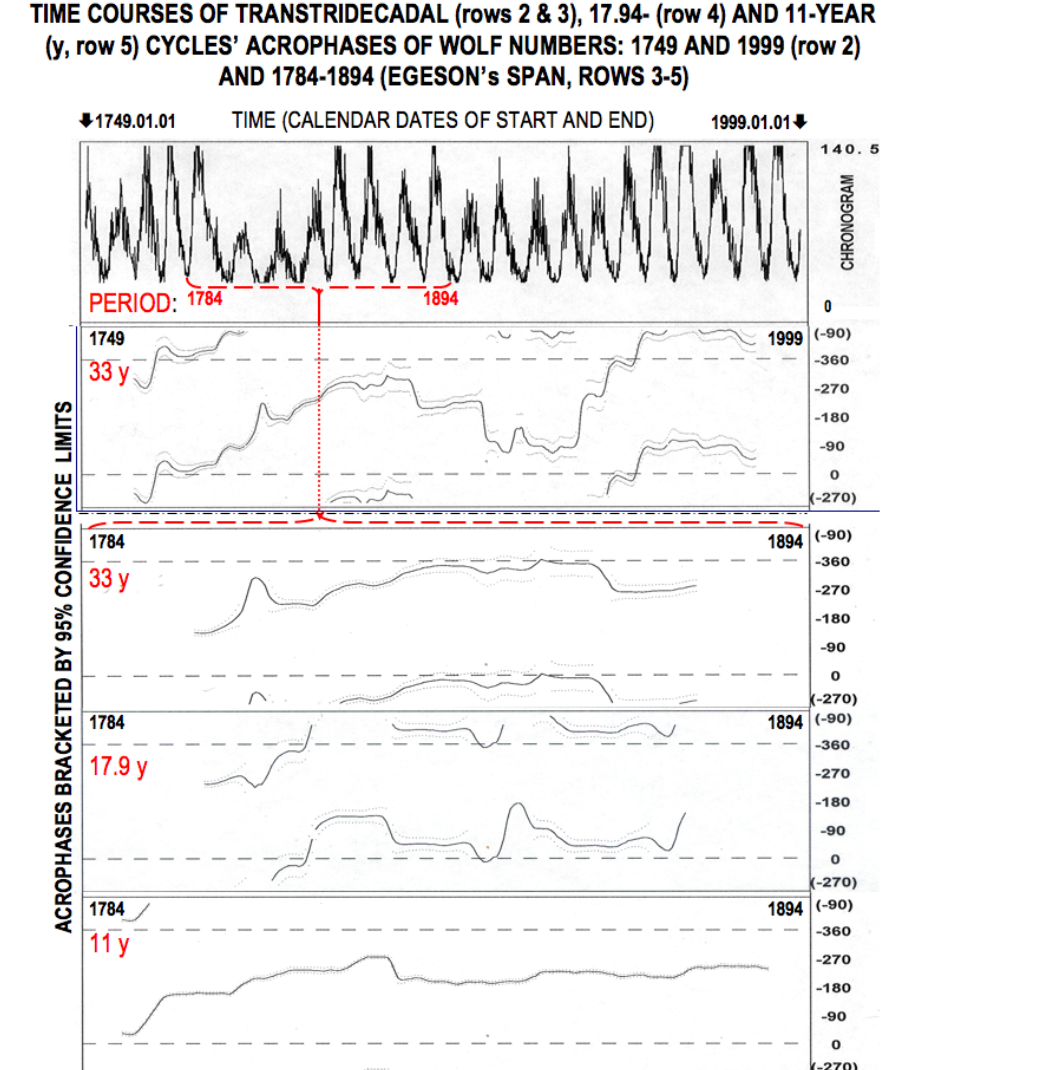
Figure 3. During the span examined by Egeson, indicated in the top row by a dashed horizontal line, the acrophase (peak) of a 33-year cosine fit scanned about 180 ◦ (row 3), as, during the same span, did the fit of other periods (rows 4 and 5), whereas in about 250 years (row 2), the phase of the 33-year cosine fit covered all of 360 ◦ . ©